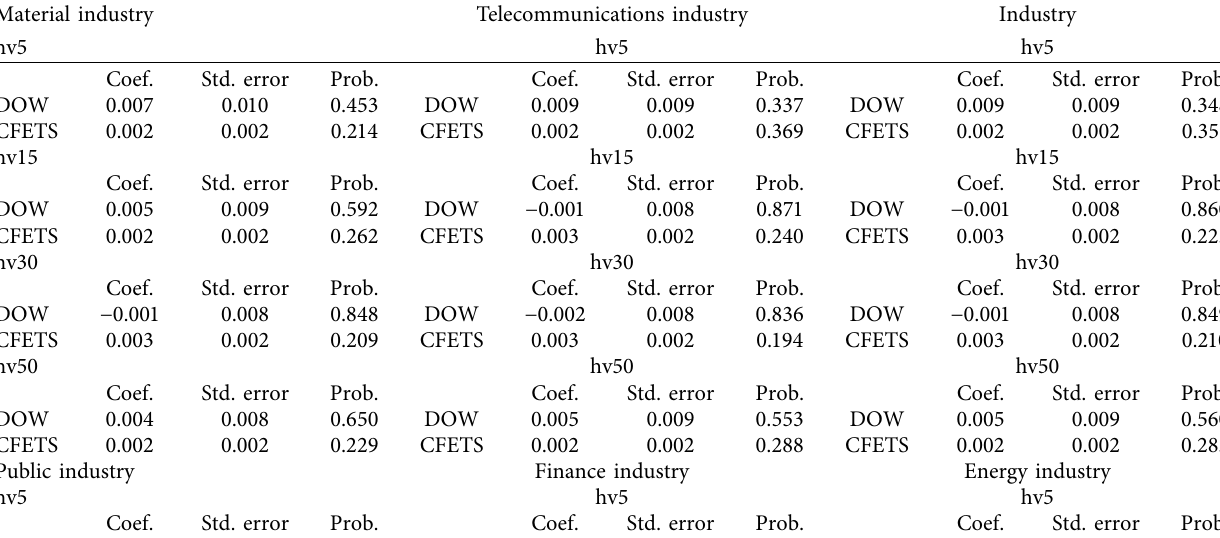
Table 5: The jump test results of the conditional density function at the